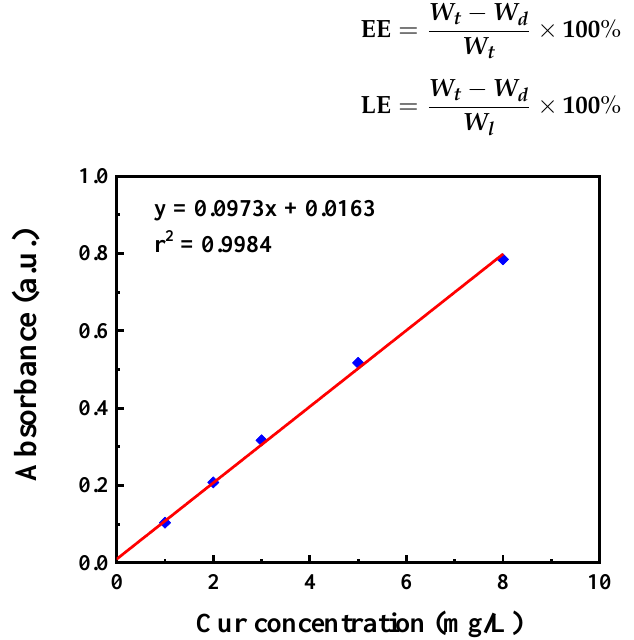
Figure 2. Standard curve of curcumin.